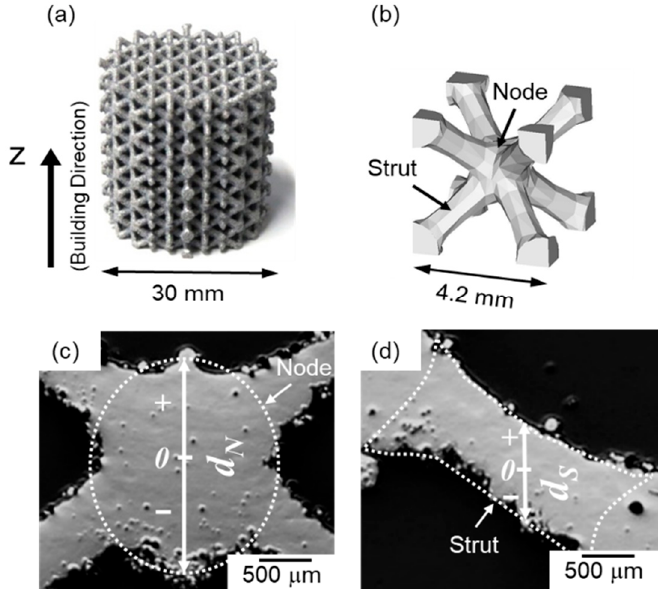
Figure 1. ( a ) Body-centered cubic (BCC)-type lattice structure manufactured in this study; ( b ) computer-aided design (CAD) model of BCC-type unit cell. Optical micrographs showing cross sections of ( c ) node portion and ( d ) strut portion of the BCC-type lattice specimen. The geometric centers of the node and strut portions were denoted as 0 (origins). The positive and negative Z-directions were denoted as + and − , respectively. The vertical distances from the geometric centers of the node and strut portions were designated as d N and d S , respectively.